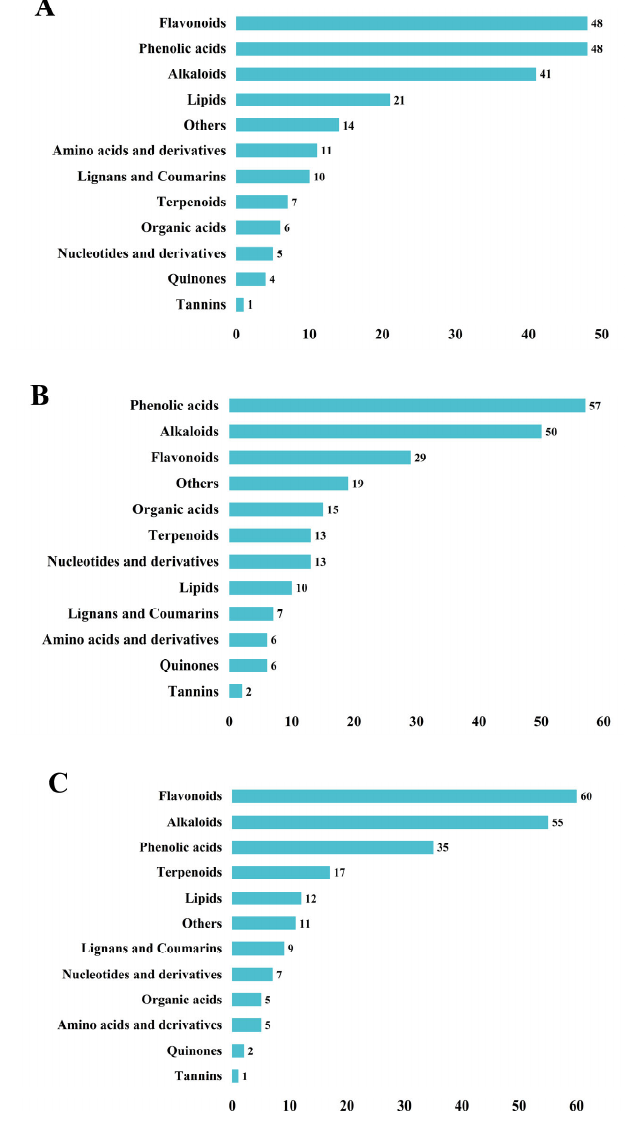
Figure 3. Identified metabolites in the ( A ) GR, ( B ) BR+3, and ( C ) BR+9.